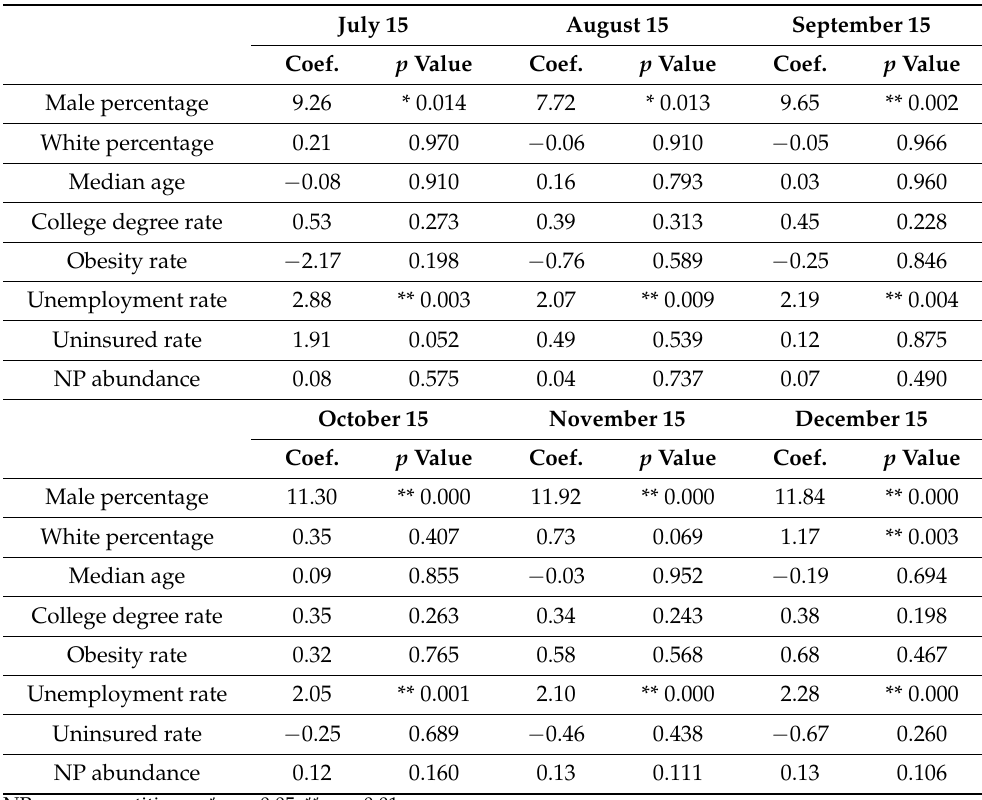
Table 2. Coefficients of the explanatory variables in SEM.